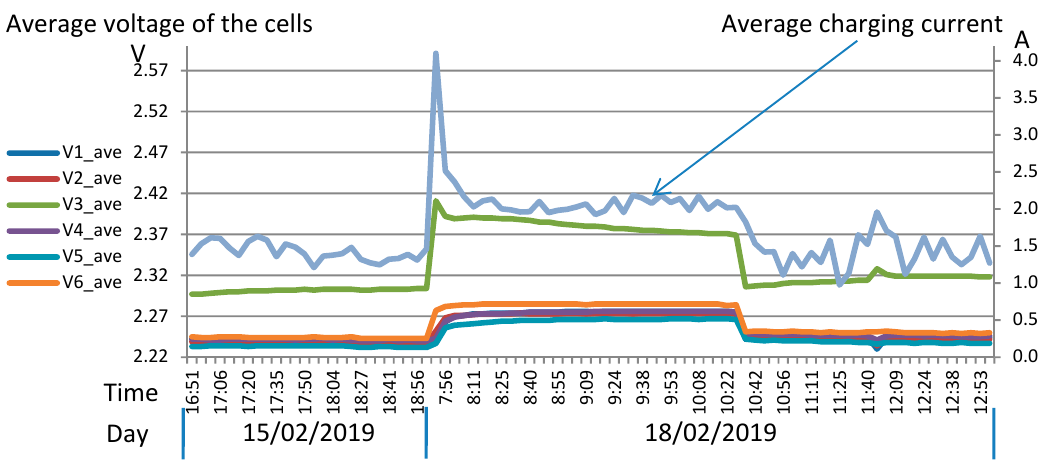
Figure 8. Results of measurements in the laboratory: float voltage of 6 cells vs. charging current.